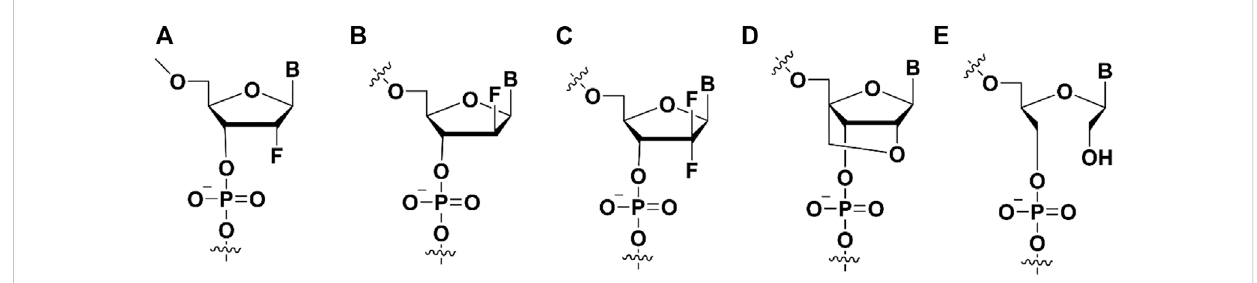
FIGURE 3 The ribose modi fi cations on the aptamers to enhance binding af fi nity. (A) 2 ′ - fl uoro (2 ′ -F) modi fi cation; (B) 2 ′ -Fluoro Arabino nucleic acid modi fi cation; (C) 2 ′ , 2 ′ -di fl uoro-2 ′ -deoxycytidine modi fi cation; (D) Locked Nucleic Acid modi fi cation; (E) Unlocked Nucleic Acid modi fi